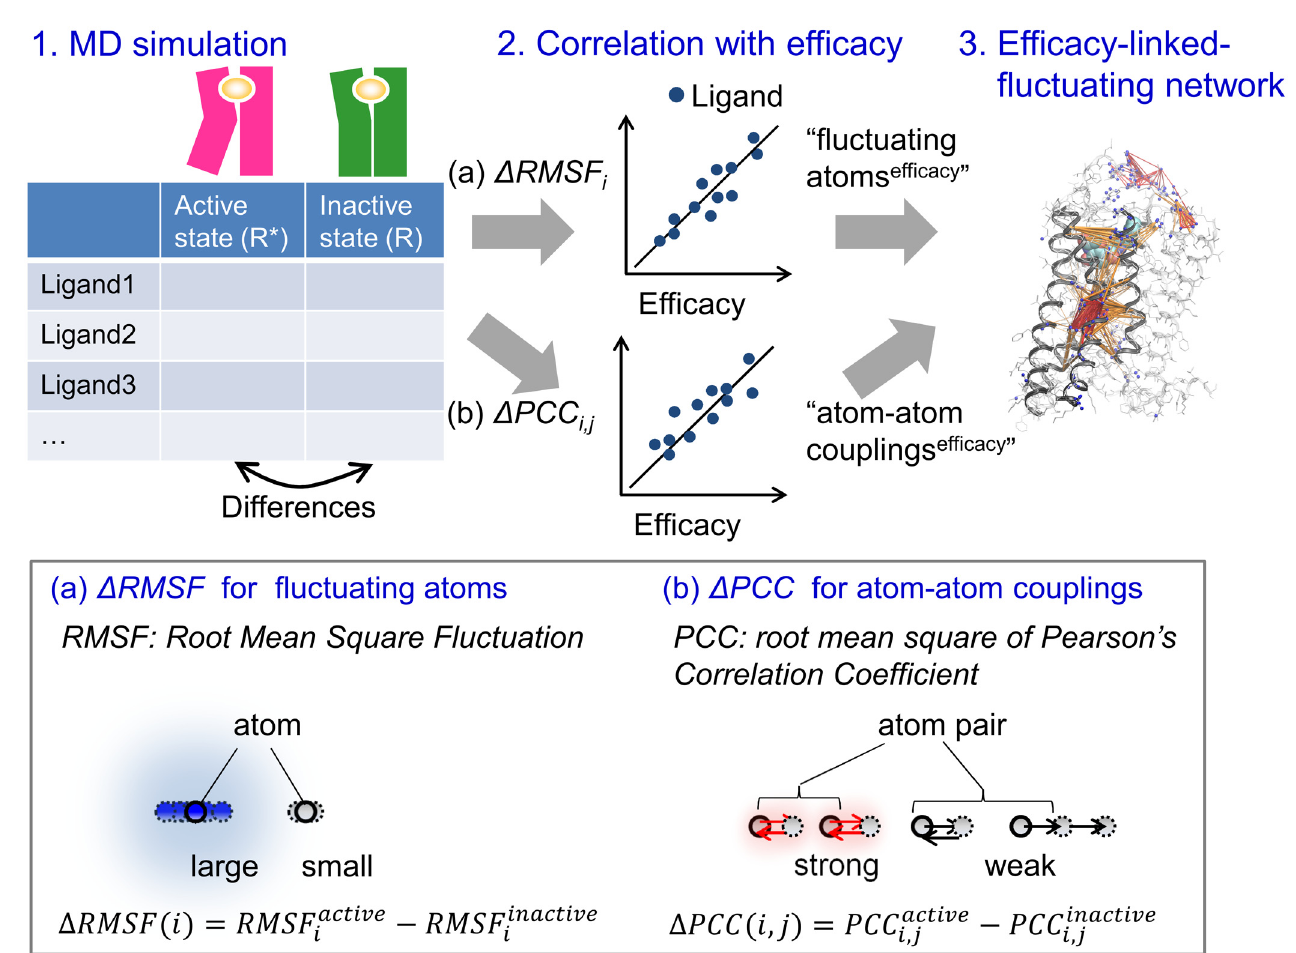
Fig 1. Schematic of the efficacy-linked fluctuating network